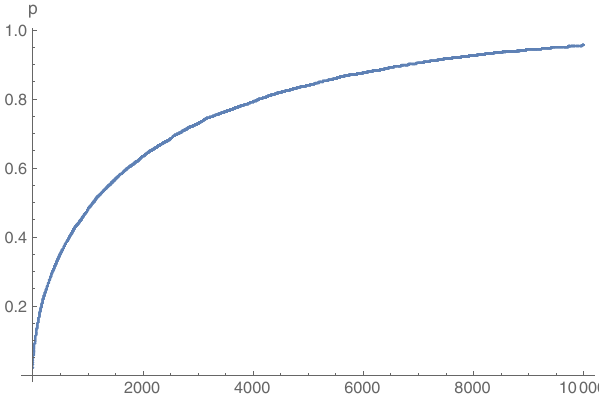
FIG. 7. The figure shows a simulation of the protocol discussed in Appendix E. Repeatedly, a state with l1-coherence 0.01 is used to increase the l1-coherence p= 2 of a given state (also initialized with coherence 0.01). If the coherence becomes negative, the state is dropped. This is repeated 10 000 times to get the average behavior. One sees that, at some point, the protocol saturates with coherence p= 2 ≈ 0 . 5